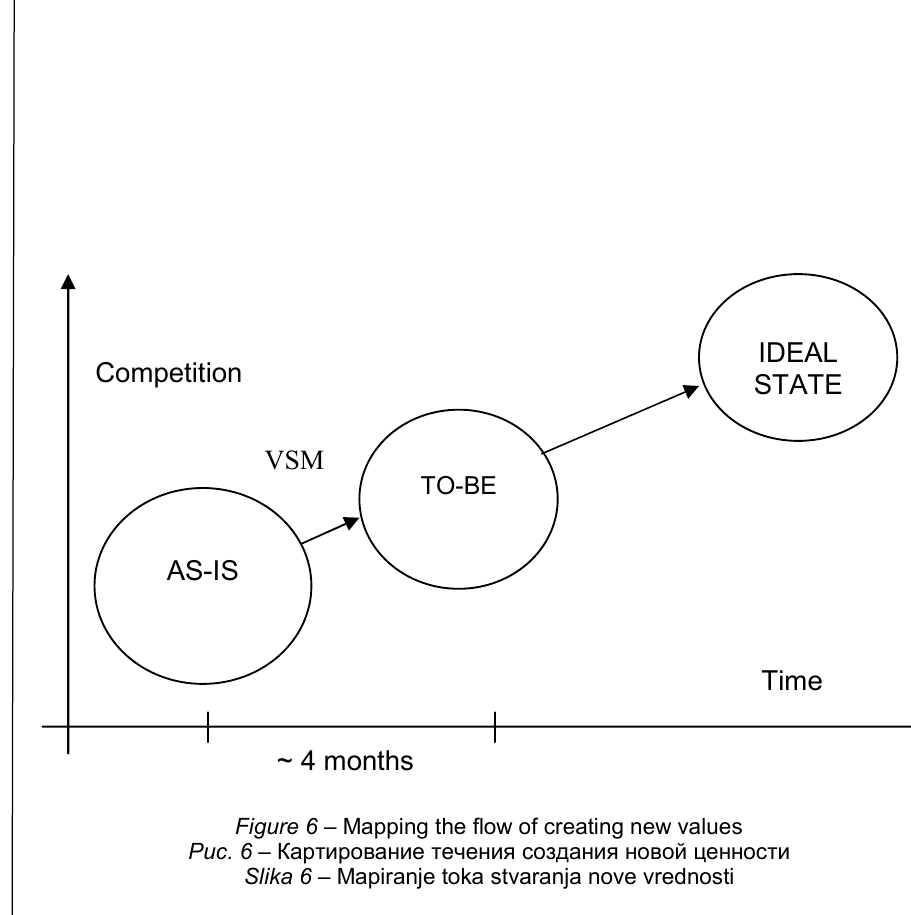
Figure 6 – Mapping the flow of creating new values Рис . 6 – Картирование течения создания новой ценности Slika 6 – Mapiranje toka stvaranja nove